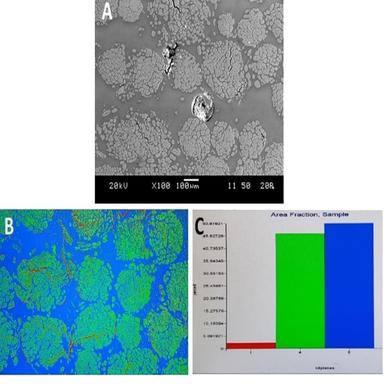
SEM images for void inspection of the Type A configuration in the flax/epoxy layers. (A) Raw image at 100× magnification, (B) Colorization using software, (C) Numerical result for constituent percentages. Similar images were obtained for the Type B configuration.